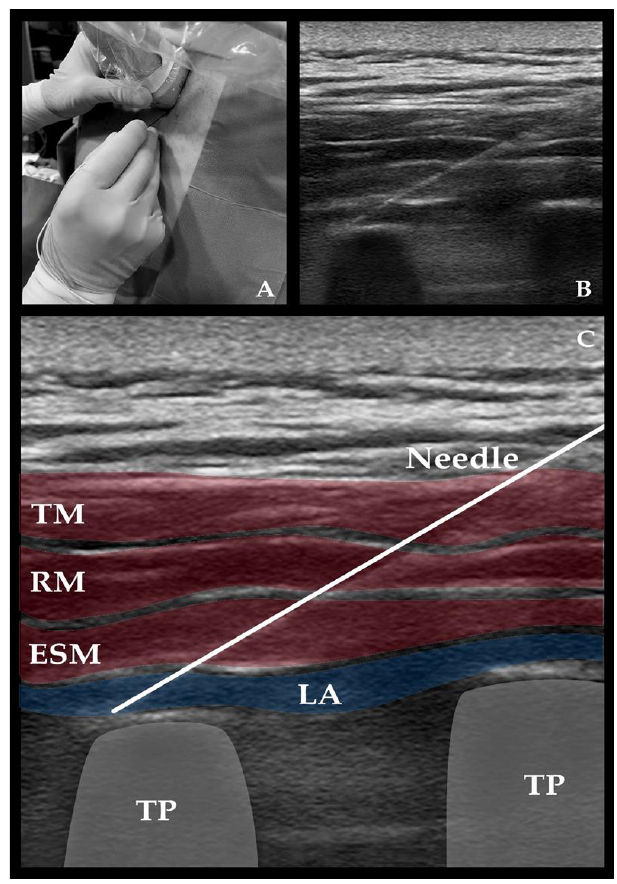
Figure 2. Ultrasound-guided erector spinae plane block. ( A ) clinical anatomy showing parasagittal scanning with a caudal-cranial in-plane approach; ( B , C ) sonographic anatomy at the level of the T 5 transverse process (TP). Local anesthetic (LA) is deposited underneath the erector spinae muscle (ESM), causing an extensive longitudinal separation of the interfascial plane. The transverse pro- cesses should appear as flat, squared-off acoustic shadows flanked by an ill-defined pleural line. Abbreviations: RM, rhomboid major muscle; TM, trapezius muscle.